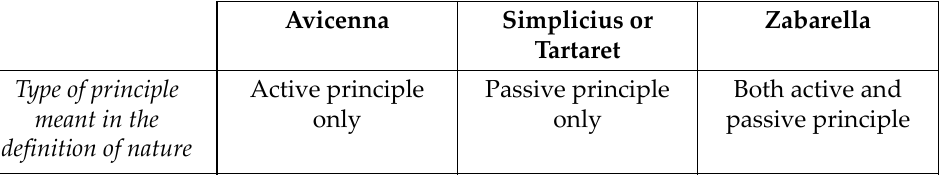
Figure 2. Comparison between competing definitions of nature.